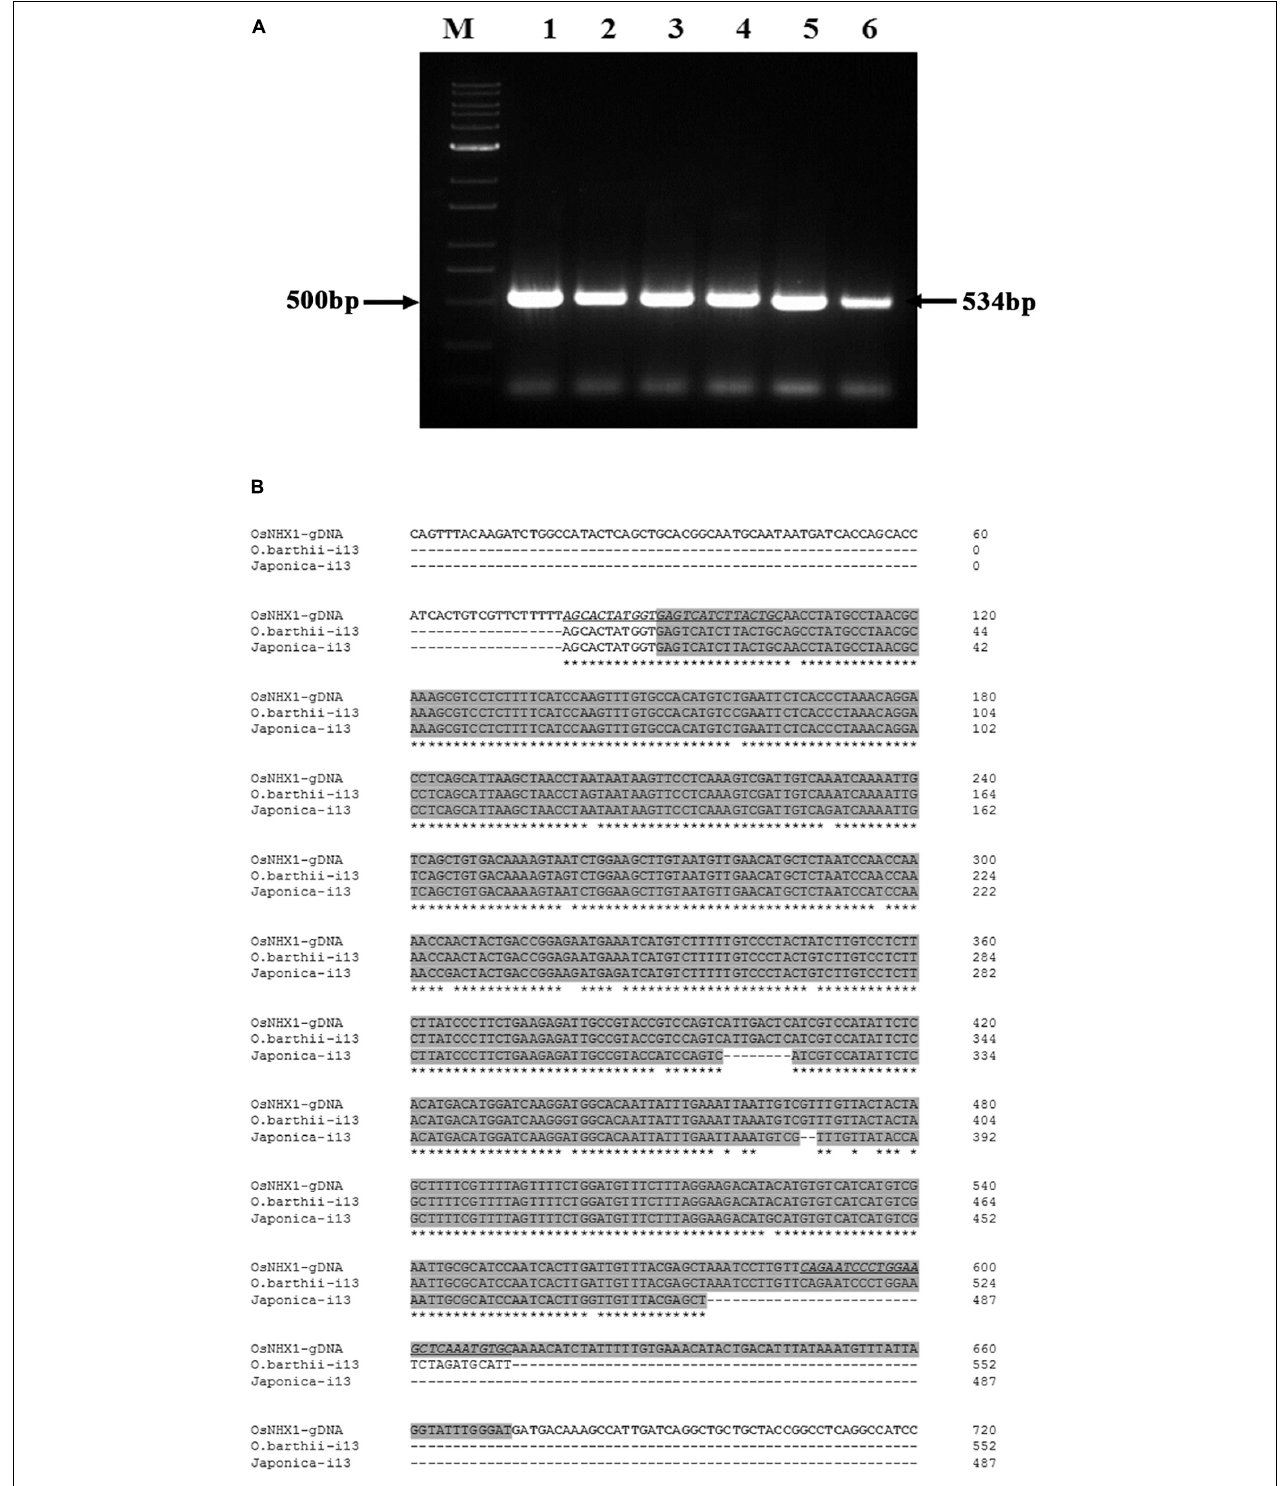
FIGURE 5 | Cloning of NHX1 13th intron retaining splice variants from Oryza AA genome types. (A) RT-PCR (DNAse I treated RNA) amplification of 13th intron retaining NHX1 fragments from O. barthii (1), O. nivara (2), O. glaberrima (3), O. sativa [ssp. japonica (4)] , O. sativa [ssp. indica cv. Pokkali (5)], O. rufipogon (6); Expected fragment size of 534 bp O. sativa [ssp. japonica ] is indicated. Primers were designed to target the 13th intron of NHX1 in all cases (12th exon-13th intron junction forward and 13th intron reverse primer. (B) Sequence alignment OsNHX1 genomic DNA and RT-PCR fragments from O. sativa [ssp. japonica ] and O. barthii from (A) were sequenced to show retention of the 13th intron. Primer sequence is underlined and the intron region is shaded gray.